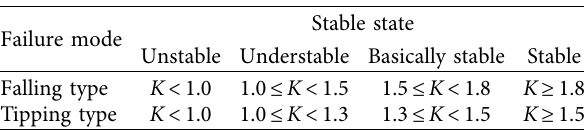
Table 6: Criteria for the stability evaluation of dangerous